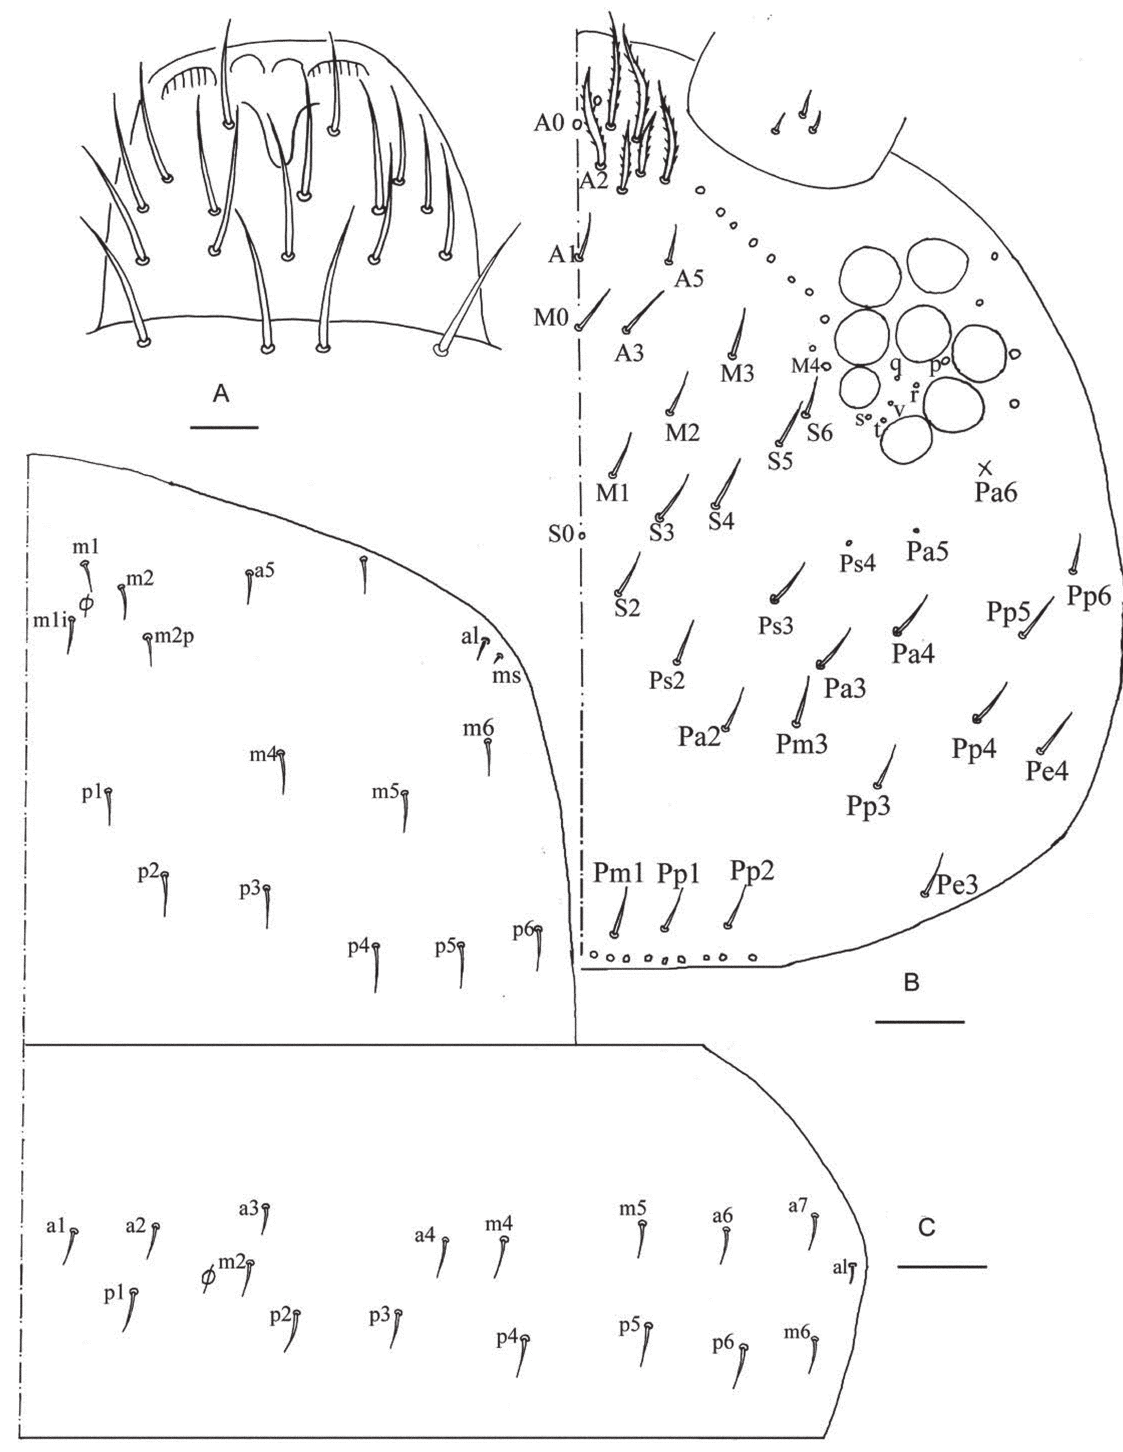
Fig. 12. Lepidocyrtus ( S. ) wanningensis sp. nov. A . Labrum. B . Dorsal chaetotaxy of head (partially, right side). C . Chaetotaxy of Th. II−III (right side). Scale bars: 20